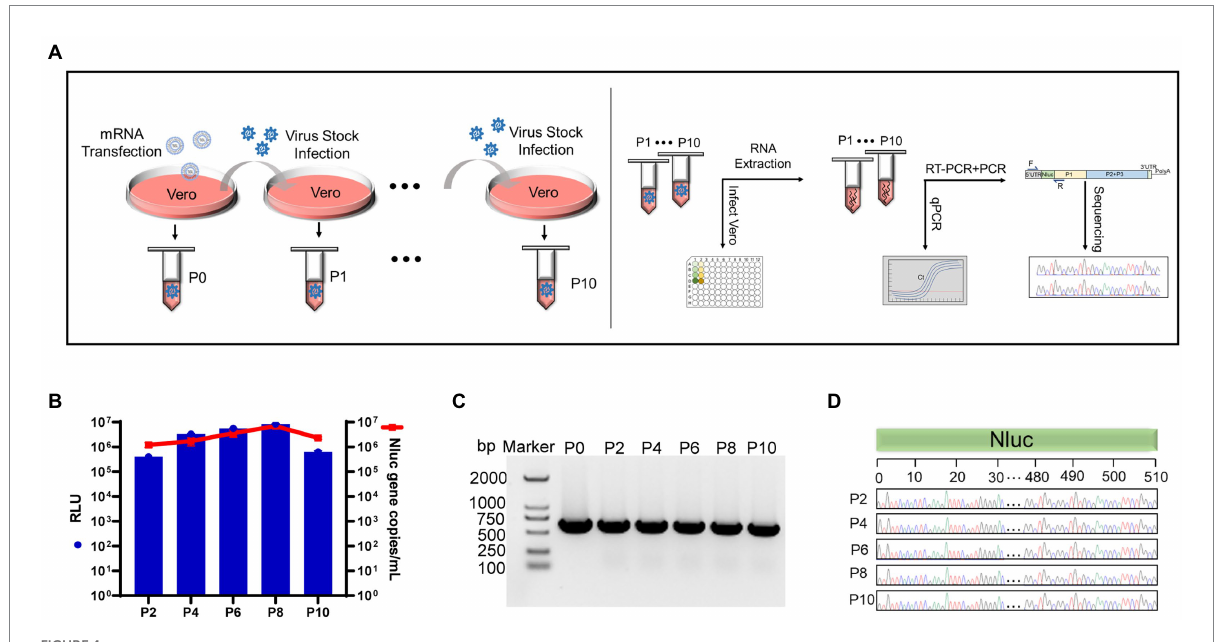
FIGURE 4 The Nluc insertion is stable in the rCA16-Nluc virus. (A) Illustrates the rCA16-Nluc stability test procedure. The left panel shows the series collection of rCA16-Nluc over 10 passages (from P0 to P10) in the Vero cells. The right panel shows the test for luciferase activity and Nluc gene in each viral passage. (B) Vero cells were infected by series passages (as indicated) of rCA16-Nluc. Luminescence (RLU value, blue bars) and Nluc gene copies (red line and square) from infected cells were measured. (C) The Nluc gene was amplificated by RT-PCR using total RNAs from rCA16-Nluc infected cells as the template, and analyzed by agarose gel. (D) Shows the Sanger sequencing of the Nluc gene from different passages of rCA16-Nluc. For better visualization, only nucleotides 0–30 and 480–510 of the Nluc gene are